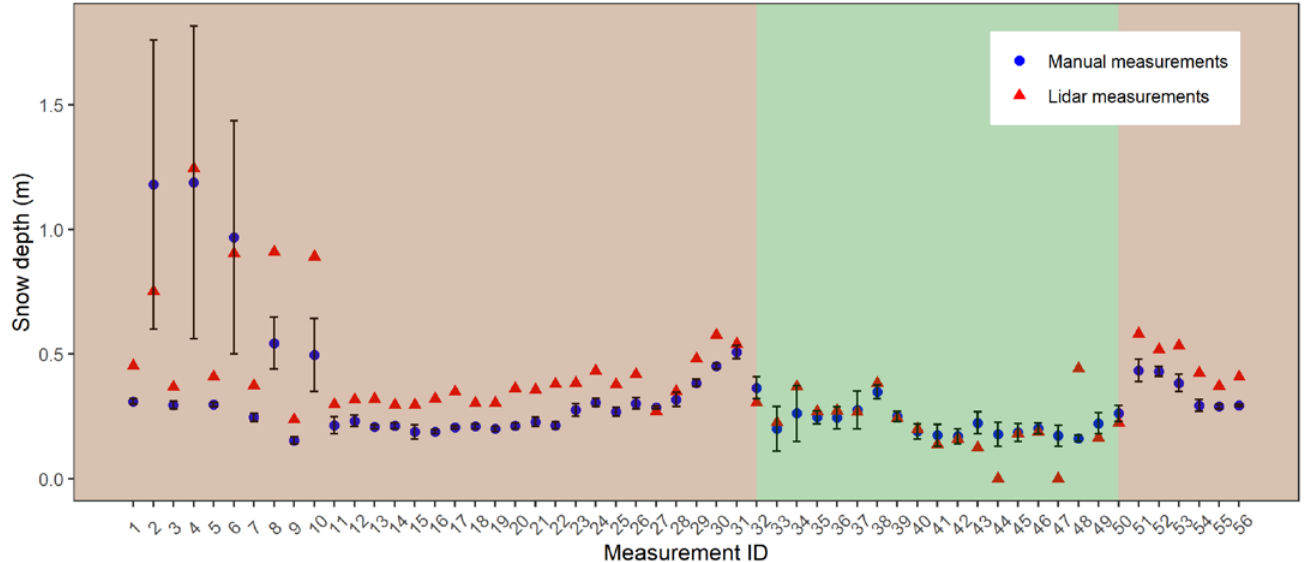
Figure 12. Variability of manual and lidar snow depth measurements in Sainte-Marthe. Error bars represent the minimum and maximum snow depth values of the five manual measurements taken at each sampling location and blue dots denote the average value of the five measurements. Measurements in the field (ID 1–31 and 51–56) and the forest (ID 32–50) are demarcated by brown and green colored shadings, respectively.